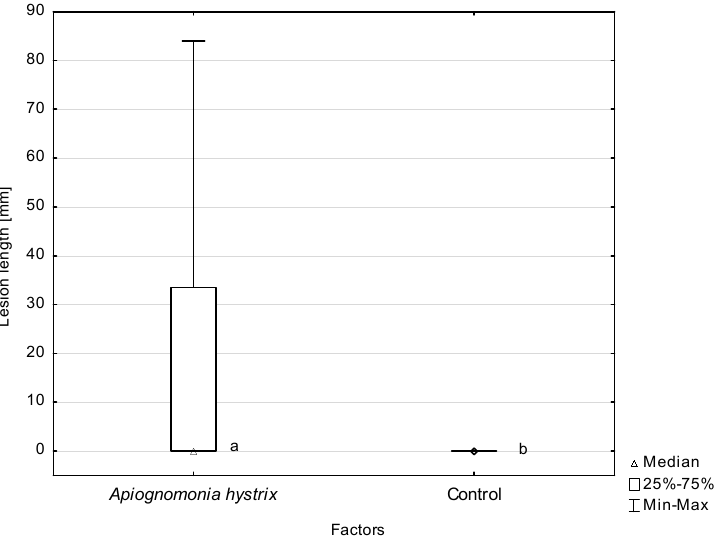
Figure 9. Lengths of necrotic lesions on petioles inoculated with Apiognomonia hystrix and in the control, eight weeks post inoculation. Values indicated with different letters have been determined significantly different at α = 0.05 in Mann–Whitney U test.